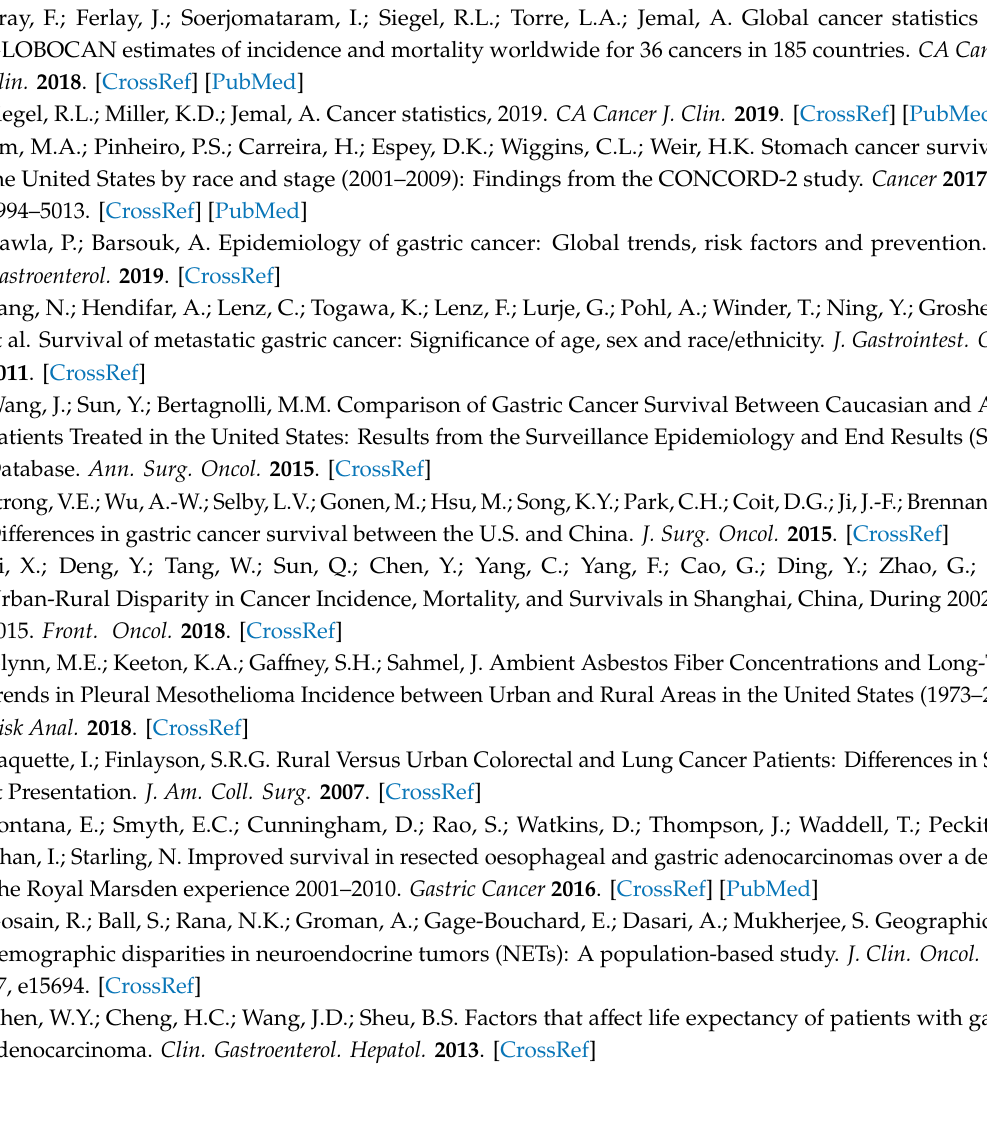
Figure S1: Stomach adenocarcinoma incidence based on the SEER database from 1975 to 2016, Table S1: Univariate Cox proportional hazards regression model highlighting OS in the gastric adenocarcinoma patient population. Figure S2 Disease-specific survival of gastric cancer patients using SEER database (from 1975 to